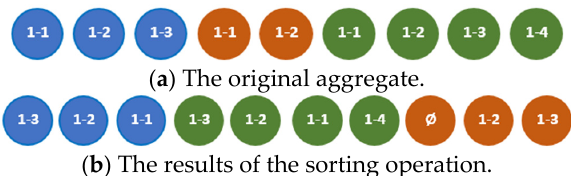
Figure 17. An example of applying the sorting operation.